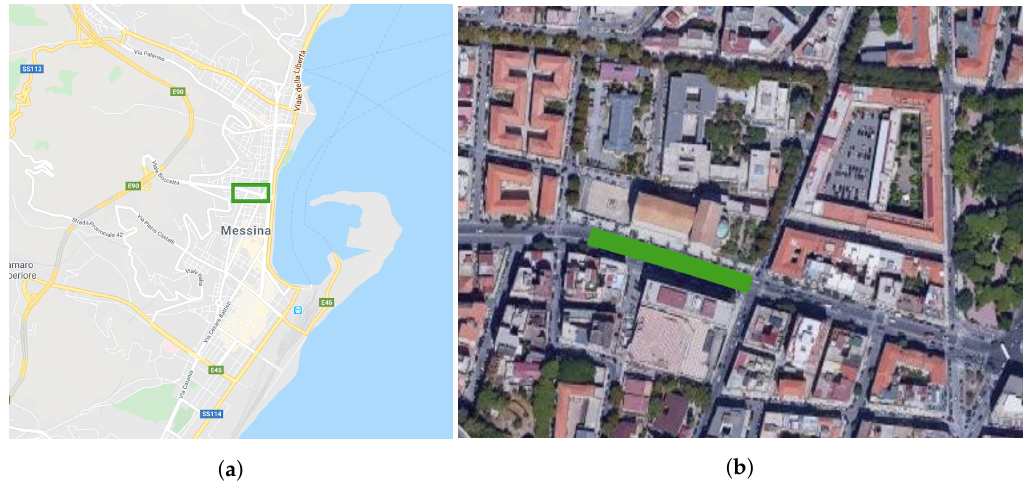
Figure 5. ( a ) Plan of the City of Messina ( left ); ( b ) detail of the monitored zone ( right ).